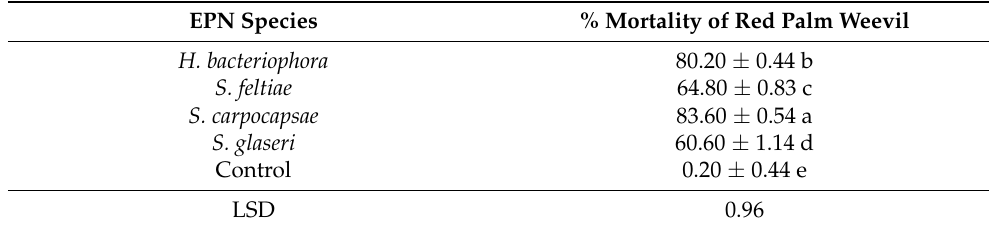
Table 3. Effect of four species of entomopathogenic nematodes on the mortality of red palm weevil under field